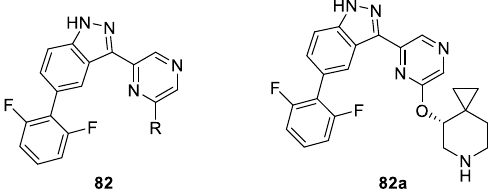
Figure 4. Chemical structures of 5-(2,6-difluorophenyl)-3-(pyrazin-2-yl)-1 H -indazoles derivatives 82 and 82a.